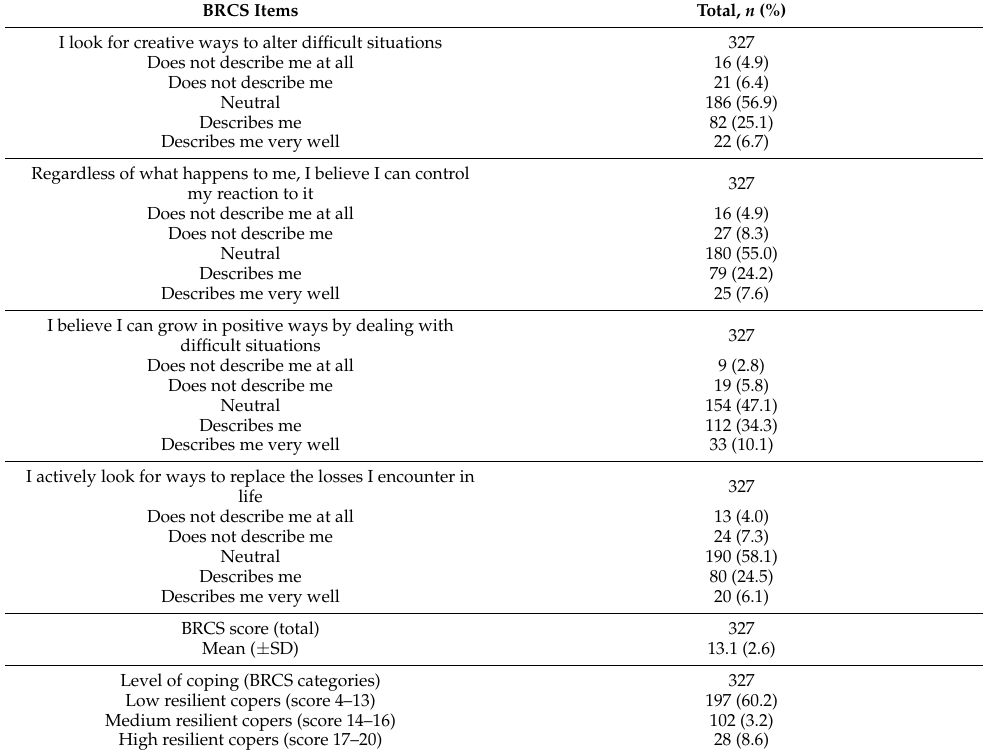
Table 4. Coping during the COVID-19 pandemic among the study